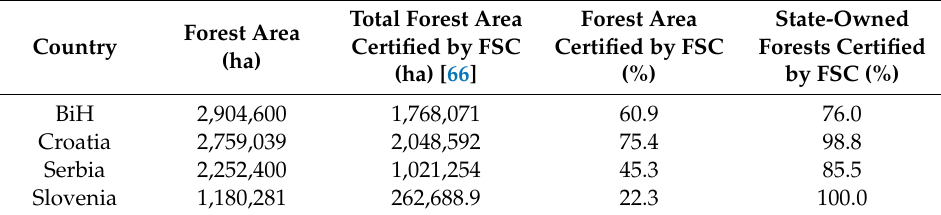
Table 1. Basic information about certified forest